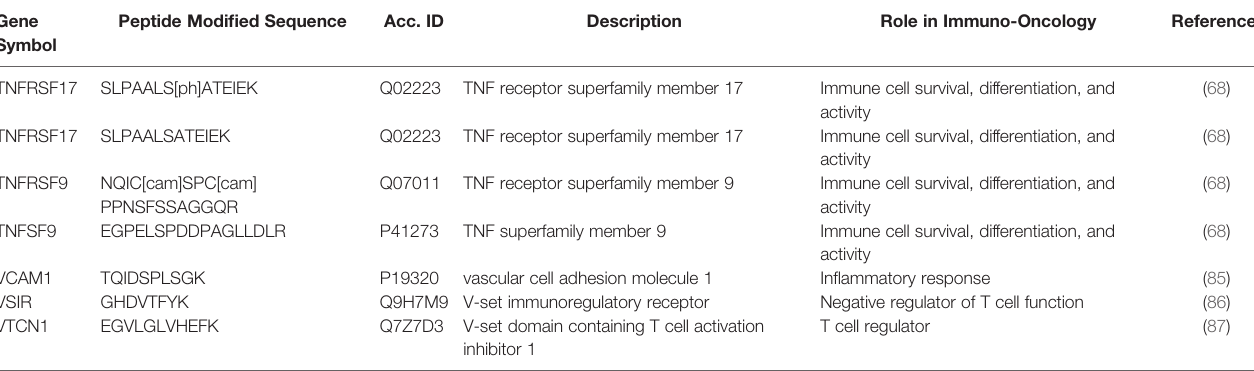
PTPRC.LFLAEFQSIPR, PSMA1.ETLPAEQDLTTK)